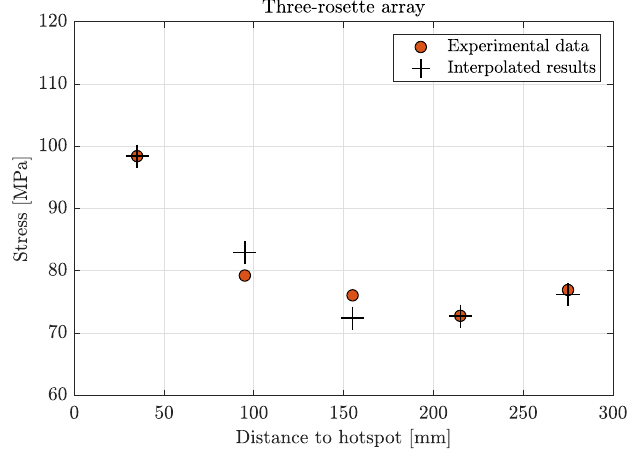
Figure 6. Comparison between the experimental measurements and interpolated results based on an optimised rosette placement.